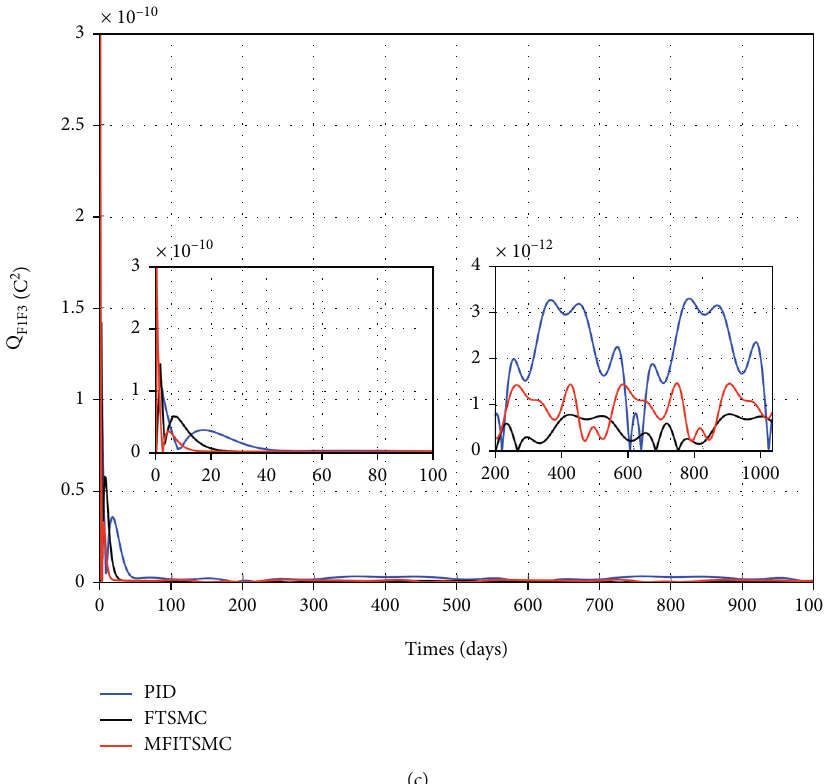
Figure 12: The time histories of charge products (Follower 1) ((a) Leader-Follower 1; (b) Follower 1-Follower 3; and (c) Follower 1-Follower 2).